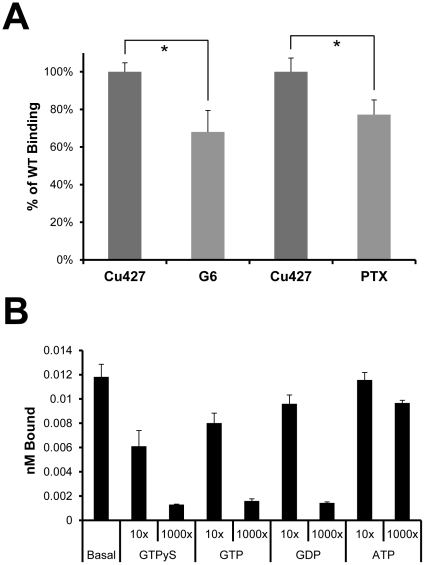
Analysis of G-protein activity in Tetrahymena microsomes.
A. 0.1 nM [35S]GTPγS binding to G6 microsomes shows a significant decrease in G-protein activity compared to wild-type. Microsomes from PTX treated cells showed a similar decrease in G-protein activity. This suggests that both conditions affect GPCR signaling by decreasing the coupled G-protein activity. n = 3 determinations of 3 different membrane preparations (* p<0.05, t-test). B. While GTPγS, GTP and GDP competed well for [35S]GTPγS binding, ATP shows little competition and therefore strengthens the support for specific GTP binding proteins. ANOVA and Dunnet's test (95 and 99% C.I.'s) were used to determine significance compared to control.